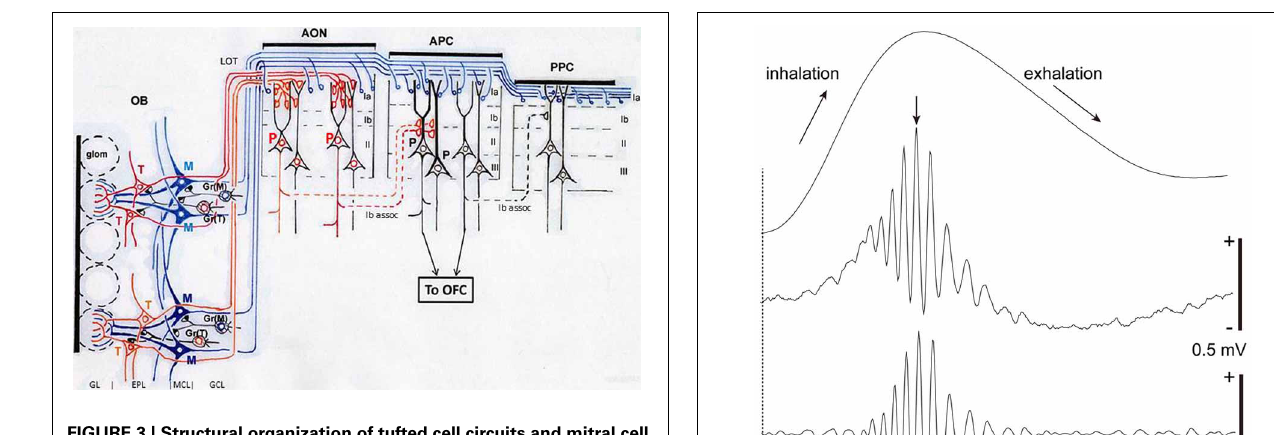
FIGURE 3 | Structural organization of tufted cell circuits and mitral cell circuits in the olfactory bulb and olfactory cortex. In the olfactory bulb (OB), tufted cells (red and orange T) extend relatively short lateral dendrites in the superficial sub-lamina of the EPL and make dendrodendritic reciprocal synaptic connections mainly with tufted cell-targeting granule cells [Gr(T)]. Mitral cells (blue M) extend long lateral dendrites in the deep sub-lamina of the EPL and form dendrodendritic synapses mainly with mitral cell-targeting granule cells [Gr(M)]. Tufted cells project axons (red and orange lines) to focal targets in the olfactory peduncle areas including AON. Mitral cells project axons (blue lines) dispersedly to nearly all areas of the olfactory cortex. Layers of the olfactory bulb: GL, glomerular layer; EPL, external plexiform layer; MCL, mitral cell layer; GCL, granule cell layer. Layers in the olfactory cortex: Ia, layer Ia; Ib, layer Ib; II, layer II; III, layer III. LOT, lateral olfactory tract; Ib assoc, Ib associational axon. Red P indicates pyramidal cells in the AON. Black P shows pyramidal cells in the APC. Glom, glomerulus; OFC, orbitofrontal cortex.